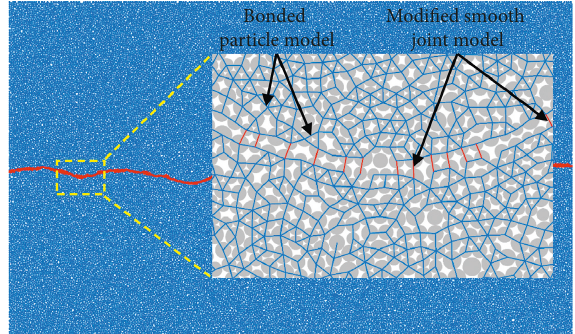
Figure 9: Numerical joint model established by the smooth joint